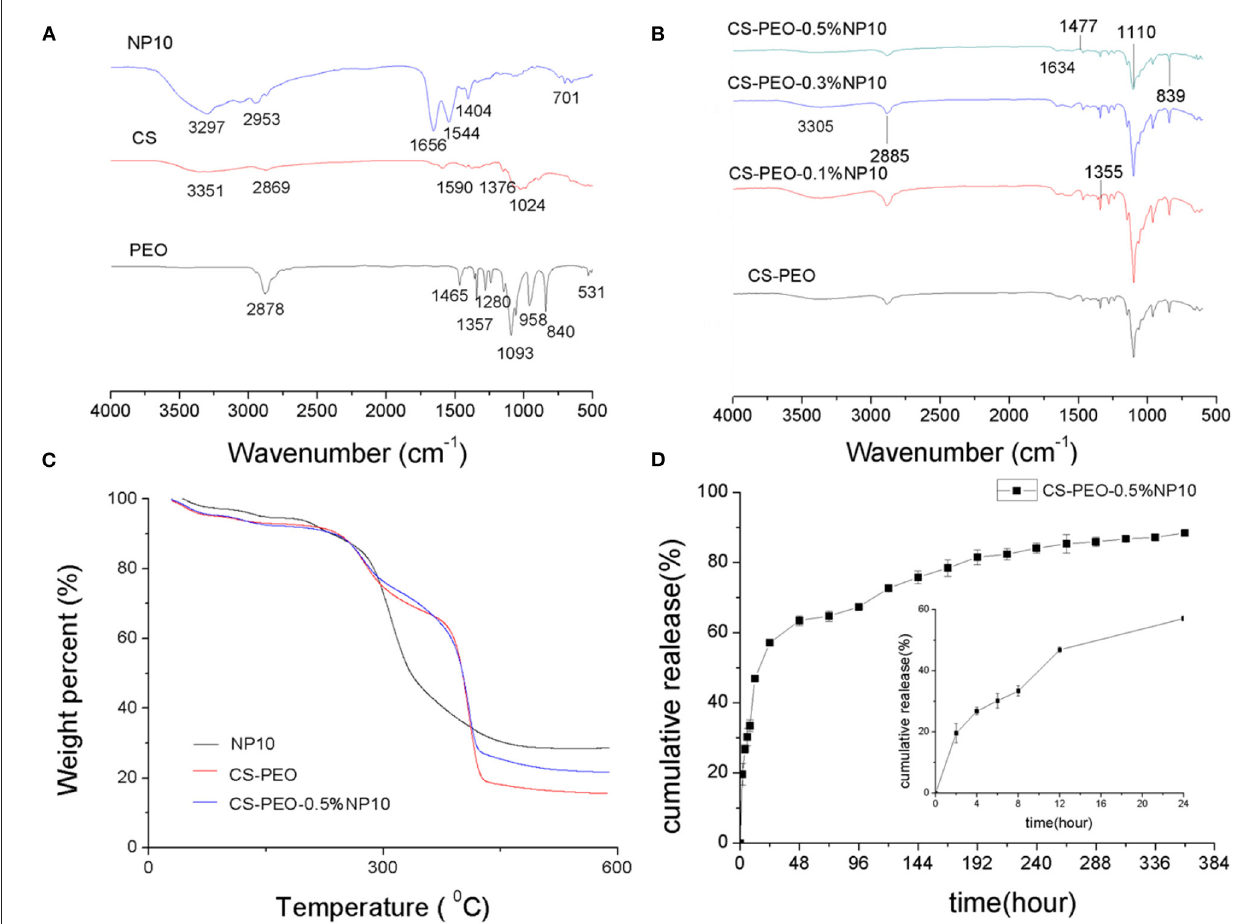
FIGURE 2 | (A) FTIR spectroscopy of the CS, PEO, and NP10 powders. (B) FTIR spectroscopy of CS-PEO nanofiber membranes containing different amounts of NP10. (C) TGA diagrams of NP10, CS-PEO and CS-PEO-0.5%NP10 nanofiber membranes. (D) In vitro release profile of NP10 (plotted as a function of percentage cumulative release vs. time) from CS-PEO-0.5%NP10 nanofiber membrane at different time ( n =